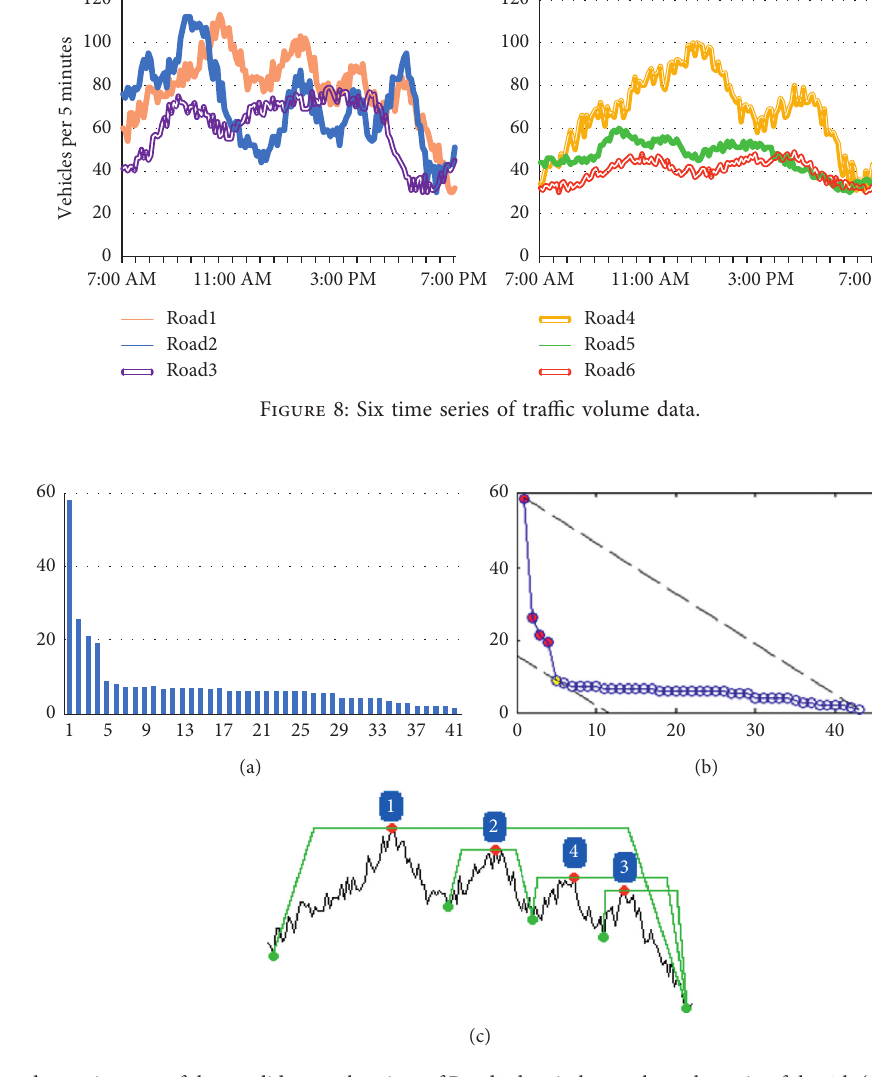
Figure 9: (a) Sorted prominences of the candidate peak points of Road1 data in bars, where the ratio of the 4th (the prominence of the last detected peak) to the 5th (the greatest prominence of the noise) is 223%. (b) Sorted prominences in dots, where the long dash line connects the first and last dots, the short dash line is a tangent line parallel to the long dash line, the yellow dot is the bending dot, and the 4 red dots correspond to the 4 peak points detected. (c) The detected peak points (each marked by its prominence ordinal number) and the supporting hills.